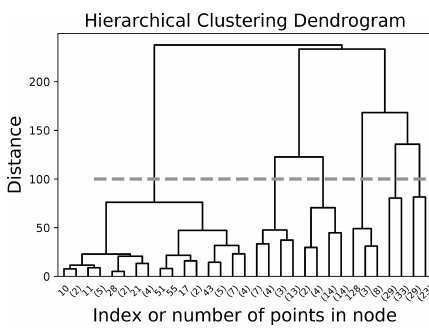
Figure A2. Dendrogram of stream gauge clustering. The dashed grey line indicates the level at which the cluster members were grouped.